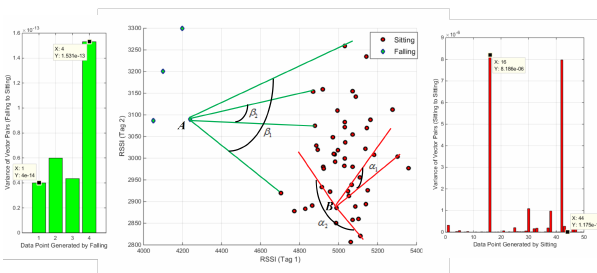
Figure 6: Intuition of angle-based outlier detection from data points of falling to data points of sitting is ranged from 4 × 10 − 14 ∼ 1 . 53 × 10 − 13 ). Therefore, we can classify different regular actions (easily collected, e.g., standing, sit- ting and walking), and detect abnormal actions (difficultly obtained, e.g., falling) by measuring the angle variances